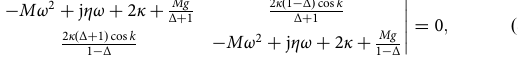
Fig. 4 Heterogeneity-stabilized homogeneous states in Faraday instability experiments. a Experimental instability boundaries in the driving amplitude vs. driving frequency space for the fl at substrate (blue), the sinusoidal substrate (orange), and the selected random substrate (green), as indicated by the corresponding colors insets. The error bars show the standard error from 4 measurements of the critical driving amplitude at each frequency, and the shaded area indicates parameters for which the shifting of the instability tongues leads to HSHS. b, c Numerical ( b ) and experimental ( c ) snapshots for HSHS for the three substrates (corresponding substrates are marked by the same color). The columns in b , c correspond to the driving parameters marked by the circle (left), the triangle (middle), and the diamond (right) in a . Videos of the experiments in c are available in Supplementary Movie Methods Pendulum array theory and numerics . The state of each pendulum in the array is described by the angle θ i with the vertical direction, where 1 ≤ i ≤ N is the pen-